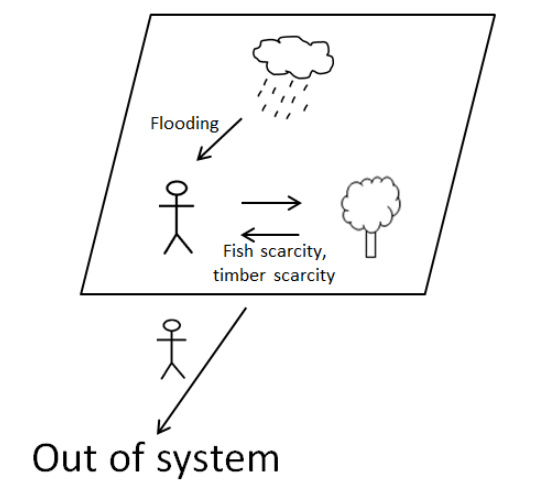
Fig. A1.11 Diagram drafted for the ABM described by Smajgl & Bohensky (2013) and Smajgl et al. (2009)